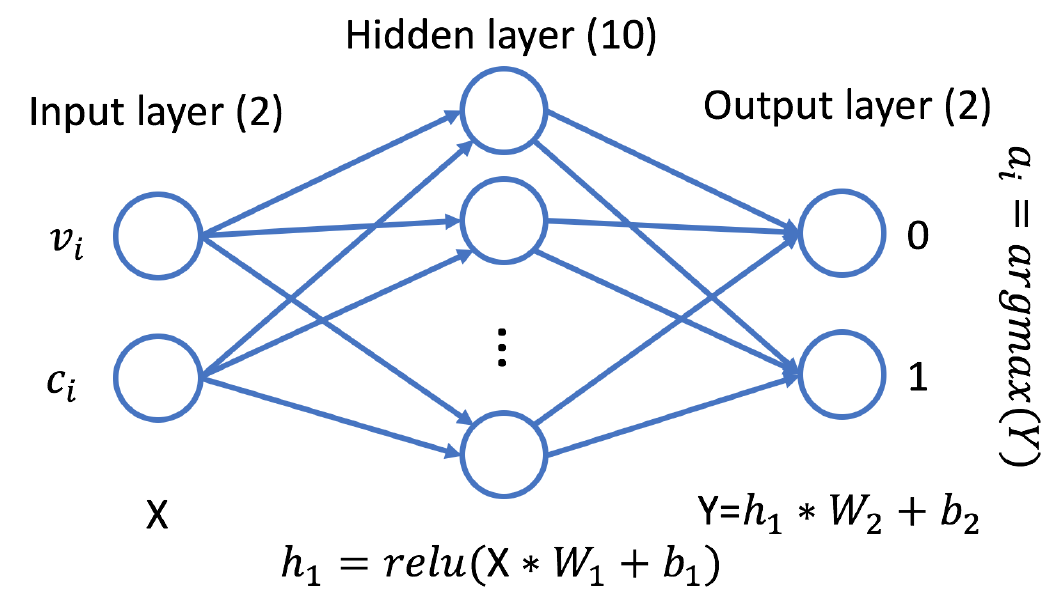
Figure 2. Diagram of the neural network on which the Q-Learning mechanism is based. The inputs are the current value and cost of contribution and the outputs are the weights given to the possible actions. The chosen action is determined by applying argmax to the output of the